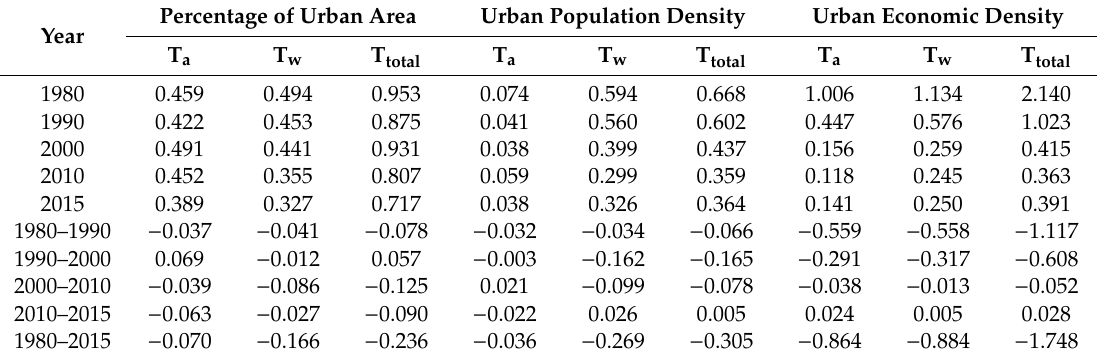
Table 5. Theil index change in urban